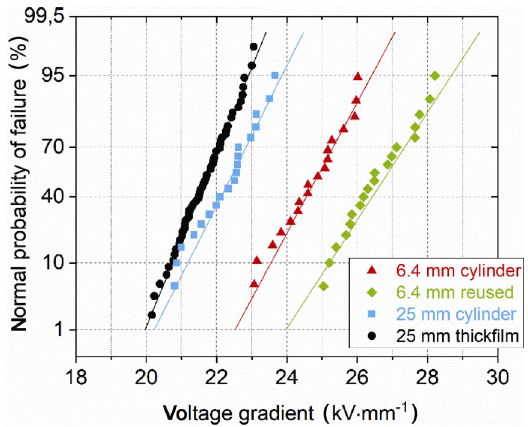
Fig. 5 Dielectric strength (AC) of 620 µm thick Al 2 O 3 measured with different electrodes. Arithmetic mean values are drawn as black dots and written in the diagram, standard deviation in parentheses. Boxes show the median, 5%, and 95% percentiles, whiskers show minimum and maximum values.